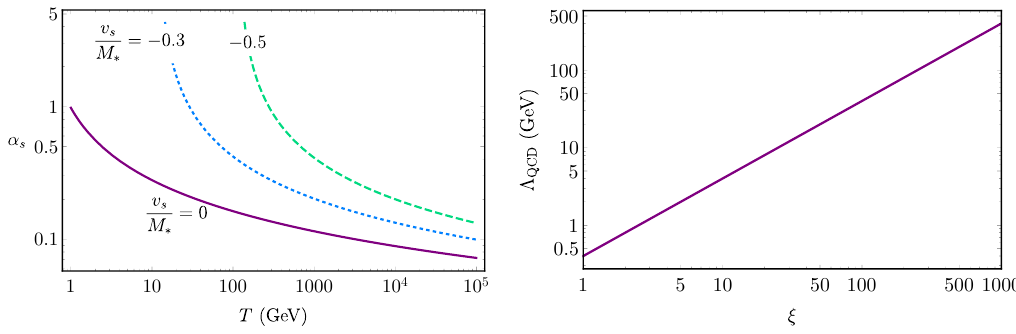
Figure 1 . Left panel : evolution of the strong coupling constant with temperature in the early Universe for three di(cid:11)erent values of v s =M (cid:3) . Con(cid:12)nement takes place at temperatures for which (cid:11) s (cid:29) 1. Right panel : the scale of QCD con(cid:12)nement, (cid:3) QCD , as a function of the parameter (cid:24) = exp(24 (cid:25) 2 = (2 N f (cid:0) 33) v S =M (cid:3) ). where G a is the gluon (cid:12)eld strength, S is a gauge singlet real scalar (cid:12)eld, and g s 0 (cid:22)(cid:23)